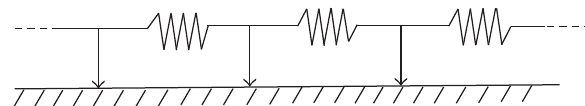
Figure 10: Iwan’s one-dimensional series-series model.